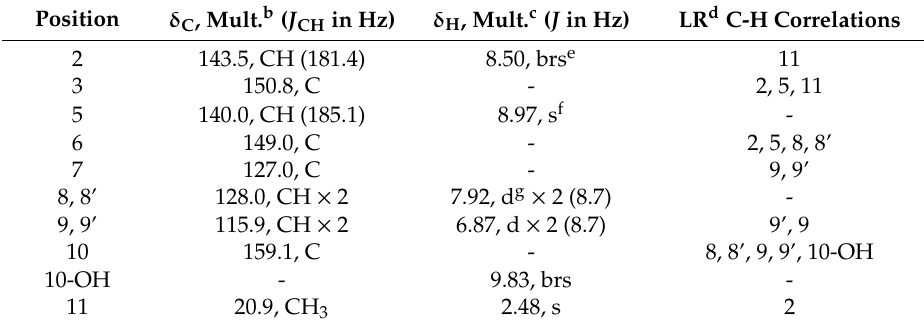
Table 3. NMR data of veronipyrazine ( 3 ) in DMSO- d 6a